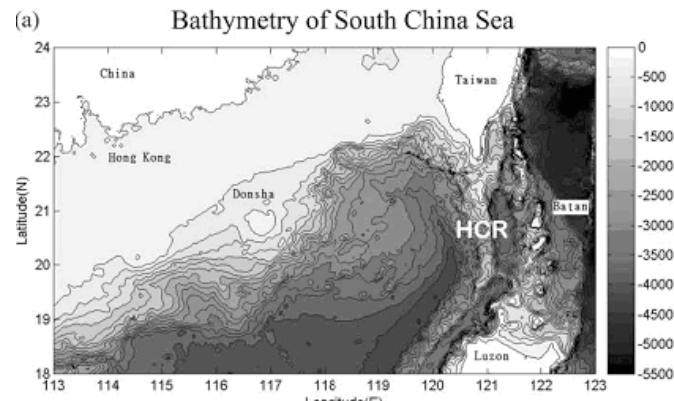
Fig. 7. Bathymetry of the northern part of the South China Sea, from Liu et al. (2006).